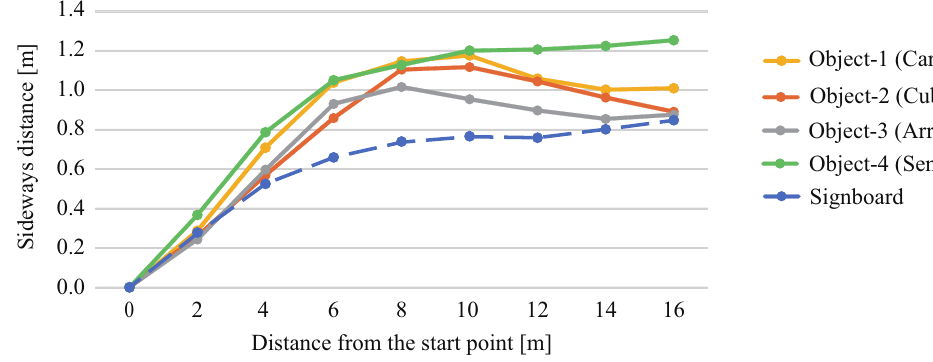
Figure 4. The average distances for each object.